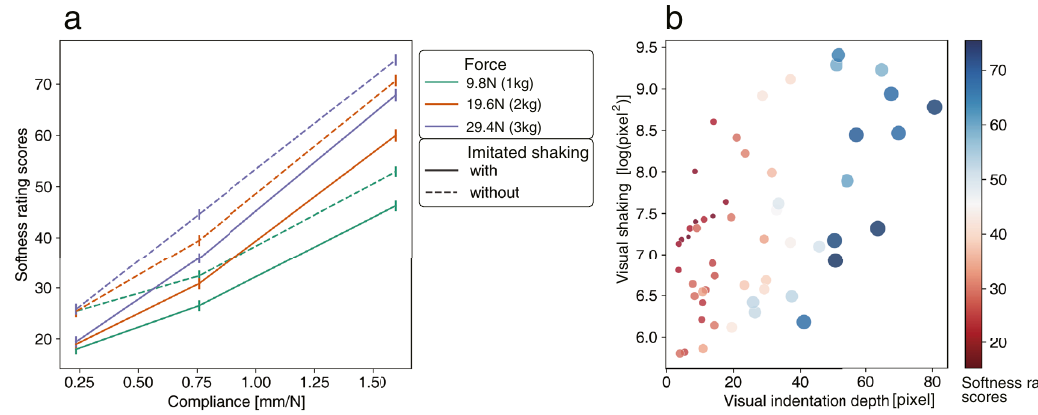
Figure 4. (a) Softness rating scores for force, material compliance, and imitated shaking conditions. Error bars denote 95%CI. ( b) Softness rating scores for visual indentation depth and visual